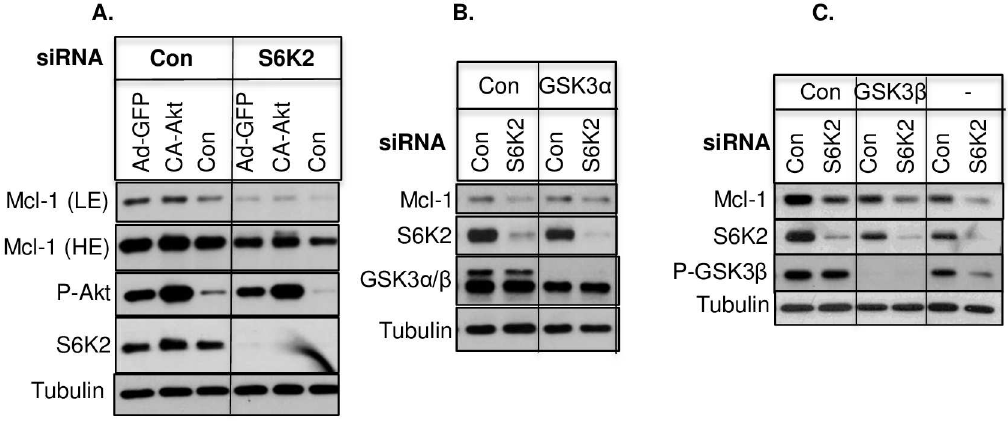
Fig 5. S6K2 knockdown-mediated downregulation of Mcl-1 does not involve Akt/GSK3. (A). T47D cells were infected with or without adenoviralvector containing GFP or CA-Akt construct. 48 h after transfection, cells were transfected with control non-targeting or S6K2 siRNA. Approximately, 72 h after siRNA transfection, cells were processedfor Western blot analysisusing indicatedantibodies.(B and C). T47D cells were transfected with or without control non-targeting, GSK3 α (B) or GSK3 β siRNA (C) for approximately 72 h and Western blot analysiswas performed. Results are representativeof 3 independentexperiments. LE, low exposure; HE-high exposure.